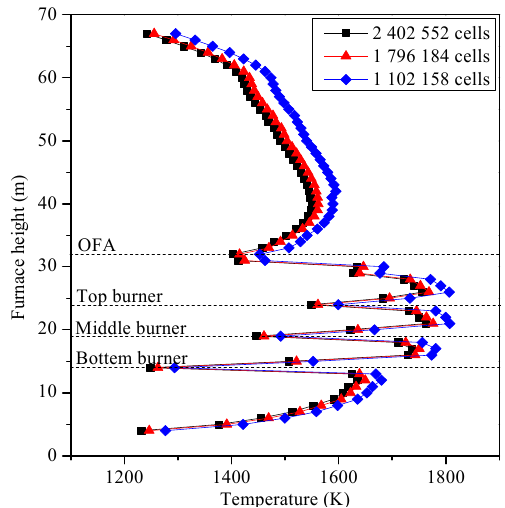
Figure 2. The mesh system of the wall fired boiler.